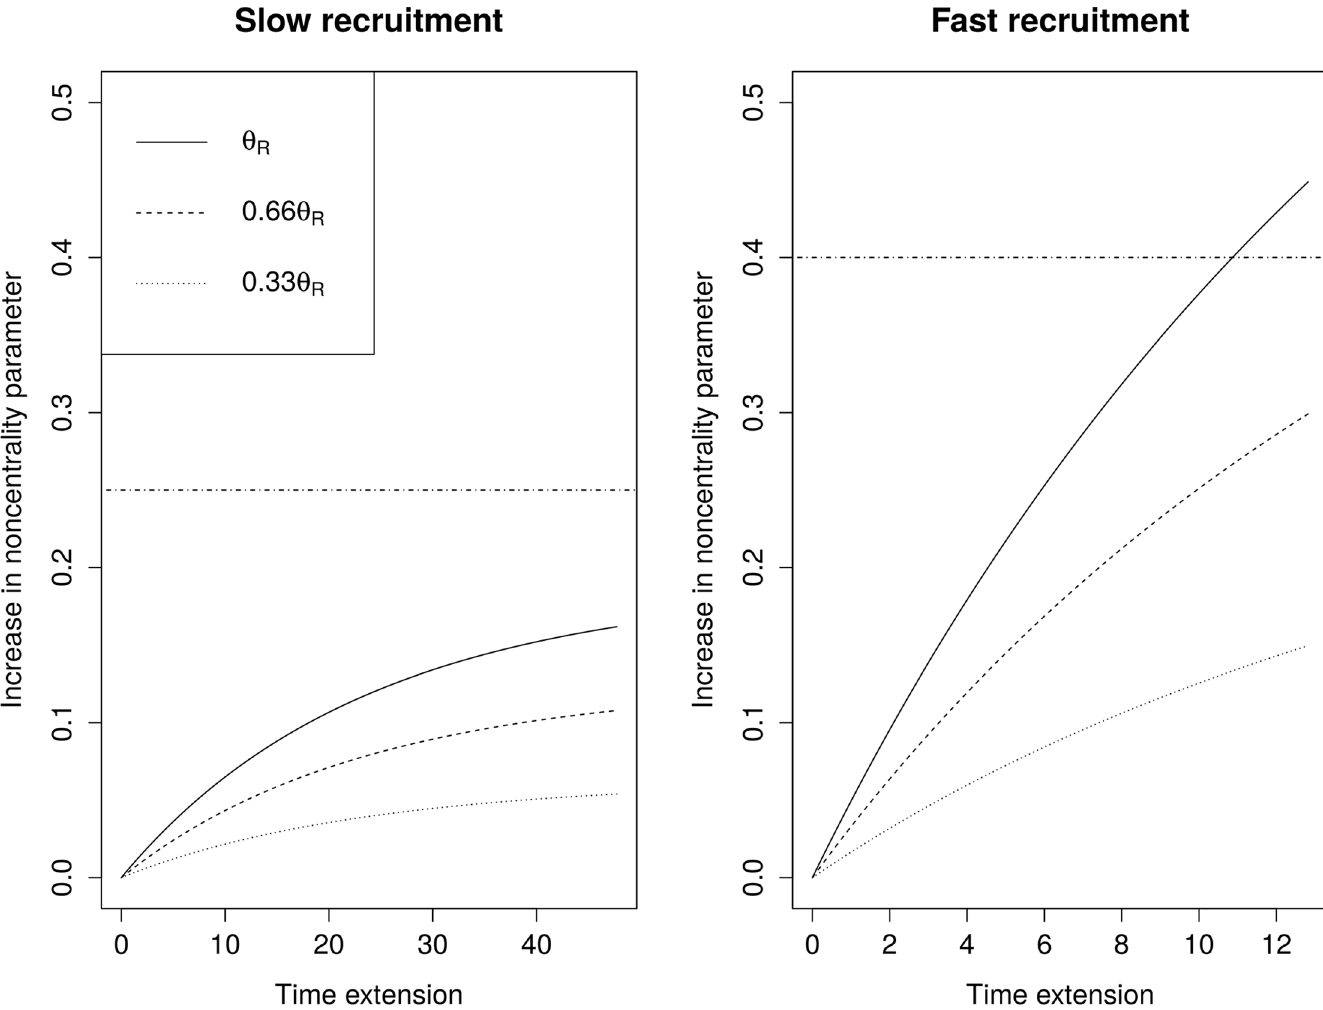
Fig 4. Difference between the noncentrality parameters of the adaptive test statistics Z ( T * ) and Z ( T end ) as a function of the time extension T * − T end 2 [0, T max − T end ]. Horizontal lines are drawn at k * − Φ − 1 (0.975), where k * denotes the cut-off value of the full-data guaranteed level- α test, and Φ denotes the standard normal distribution